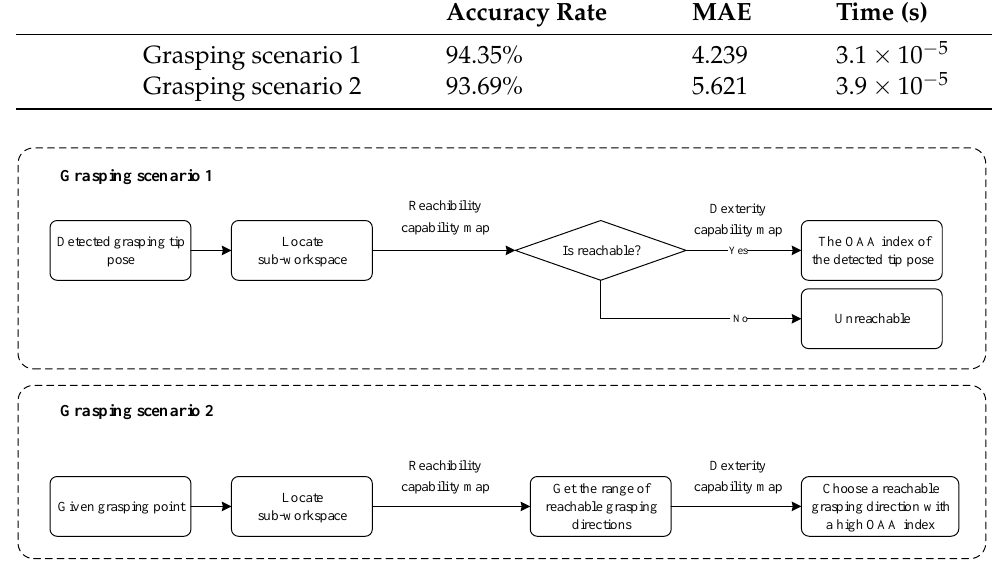
Figure 18. The planning processes frameworks of the pre-planners composed of reachability capabil- ity map and dexterity capability map in two grasping